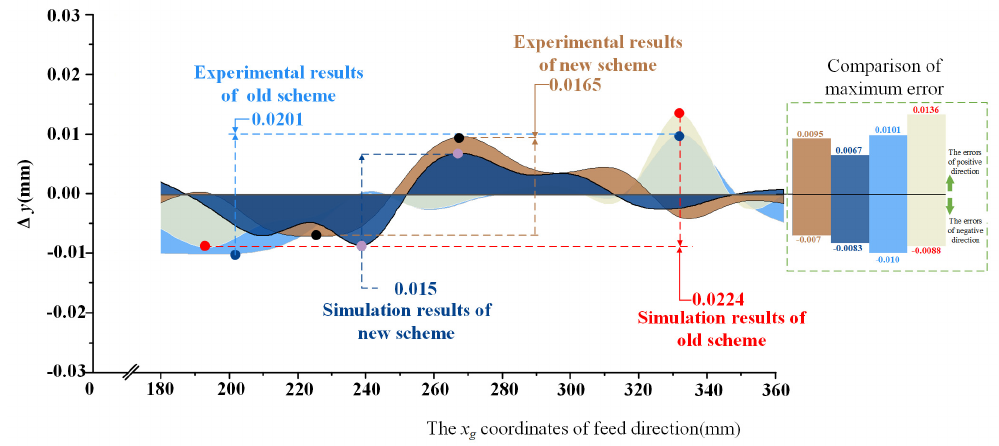
Figure 15. Positional reference point error of the old and new process schemes.